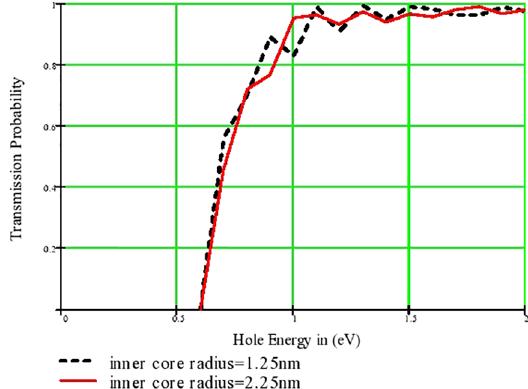
Figure 5. Dependence of holes transmission probability on